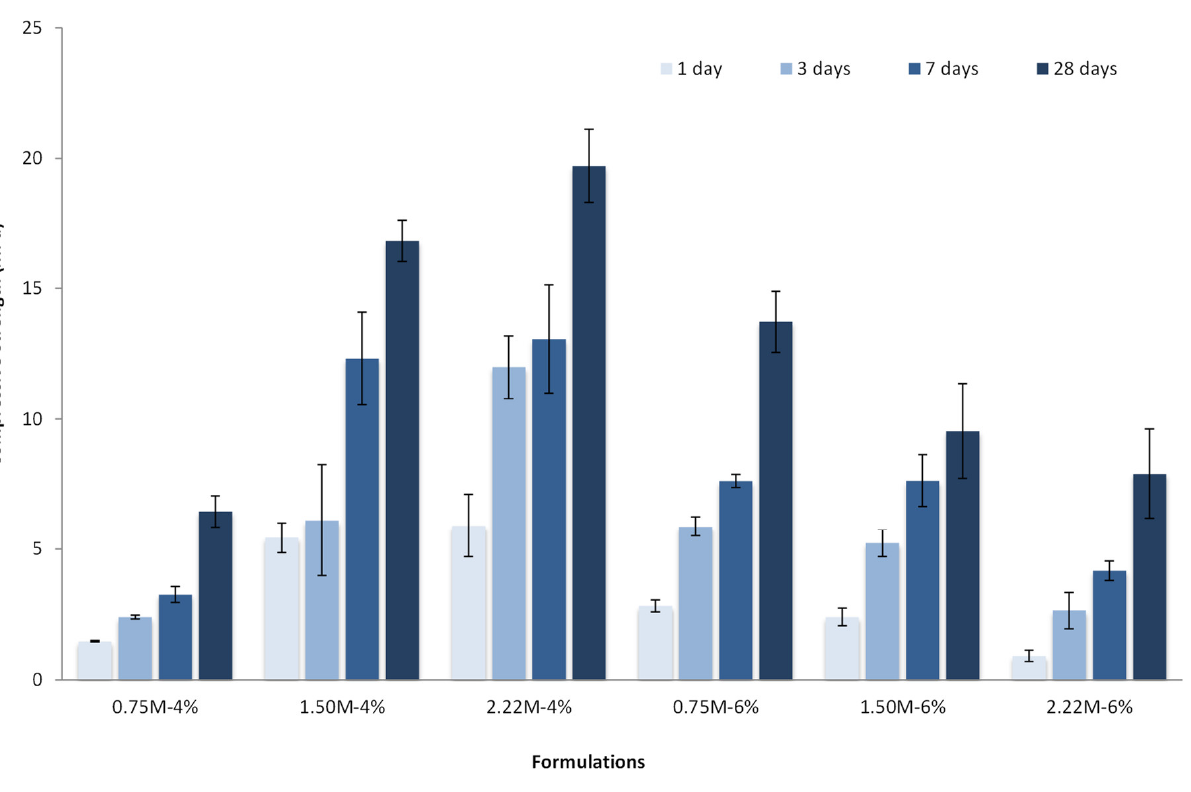
Figure 5 . Compressive strengths of the pastes. Figure 5. Compressive strengths of the